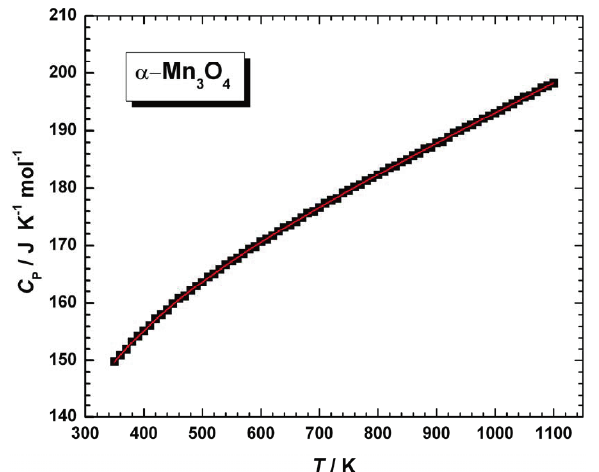
Figure 2. Heat capacity of Mn 3 O 4 measured using